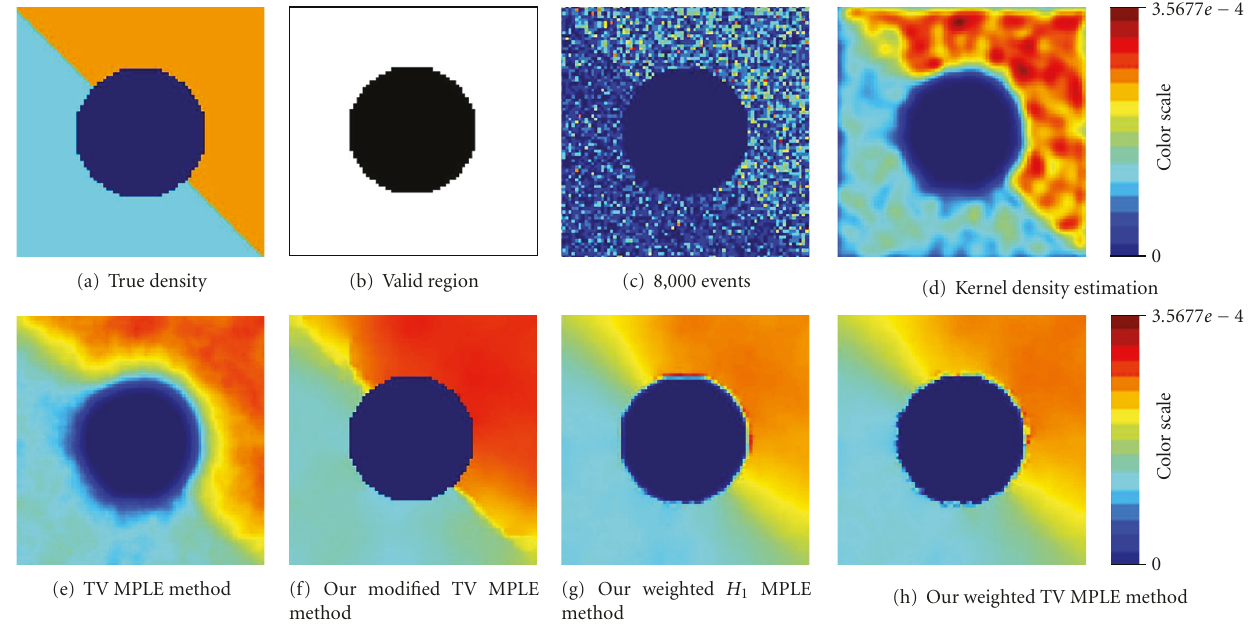
Figure 2: This is a model-validating example with dense data set of 8000 events. The piecewise-constant true density is given in (a), and the valid region is provided in (b). The sampled events are shown in (c). (d) and (e) show the two current density estimation methods, Kernel Density Estimation and TV MPLE. (f), (g), and (h) show the density estimates from our methods. The color scale represents the relative probability of an event occurring in a given pixel. The images are 80 pixels by 80 pixels.